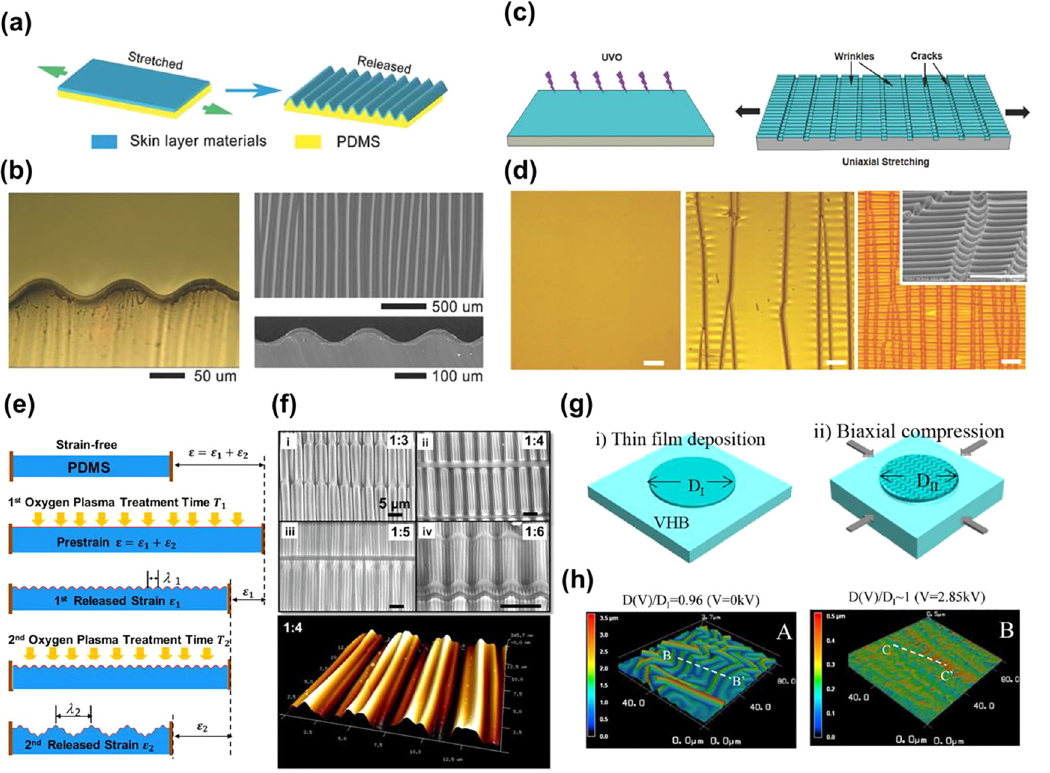
Figure 3: Fabrication of 2D scatterer based on surface wrinkles. (a) Schematics of 1D wrinkled film fabricated by pre-stretch/release process. (b) Optical microscope and SEM images of the as-prepared wrinkled PVA/PDMS film. (c) Fabrication processes and reversible tuning of optical transmittance of a PDMS film with surface wrinkling – crackingpatterns.(d)OpticalmicroscopyimagesofthePDMSfilmsurfaceundervariousappliedstrains(scalebar:200µm).(e)Schematicsof thefabricationprocessto generatehierarchical 1Dwrinkles onPDMSthroughtwo-stepstrain releaseandtwo-step oxygenplasmatreatment. (f) SEM images of hierarchical wrinkles with different wavelength ratios and AFM images of 1:4 hierarchical wrinkles. (g) Fabrication procedures for 2D wrinkles from thin- fi lm deposition to radial compression-induced surface wrinkling. (h) Confocal micrographs showing the morphology of the as-prepared thin fi lm in 2D wrinkled and unfolded states. Reprinted with permission from Refs. [18, 57, 60,